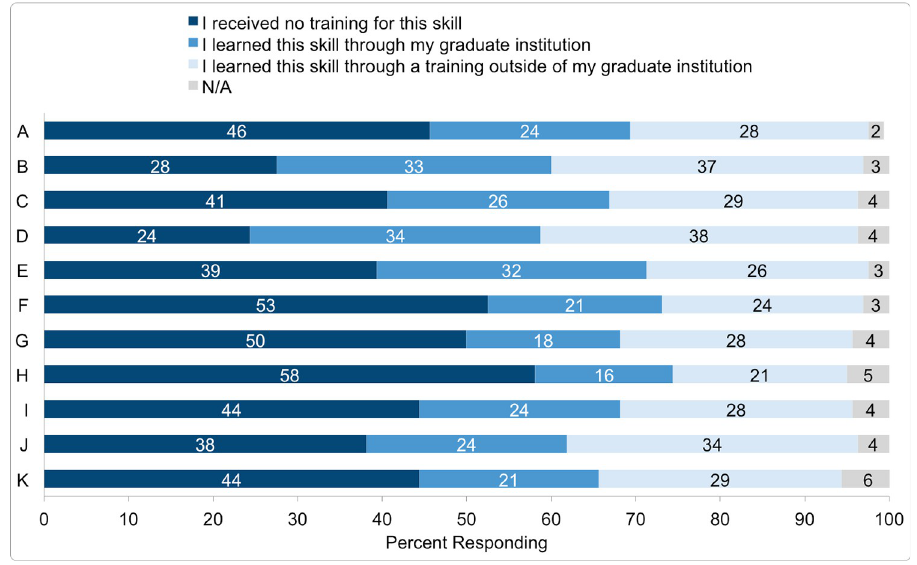
Fig 4. Participants previous training in specific science communication skills. Participant responses when asked where, if at all, they received training in 11 core skills in science communication, listed A-K [33]. Data are shown as percent responding.